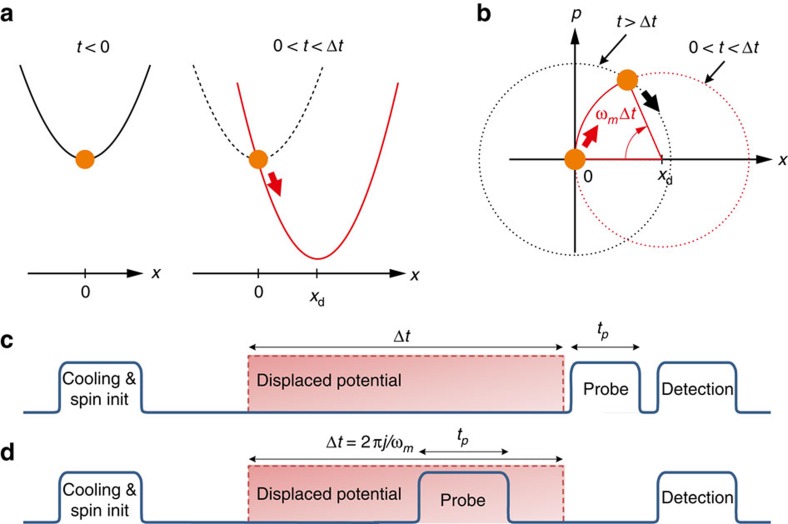
Experimental bang–bang sequences.(a) The ion is first cooled close to the ground state of motion in a harmonic trapping potential centred at x=0, and the internal electronic state is pumped to the ground-state |↓〉. At t=0 the potential center is suddenly displaced to xd and the ion's motional state is the coherent state |−α0〉. (b) Evolution of the motional wave function in the position-momentum phase-space. After a time Δt in the displaced potential, the trap centre is switched back to x=0, leaving the ion in a coherent state of size given by equation (1). (c) Sequence of laser pulses and potential displacements for monitoring the time evolution of coherent states. (d) Sequence for studying the light-matter interaction with highly excited states. In this sequence, Δt is an integer number j of multiples of the oscillator period.